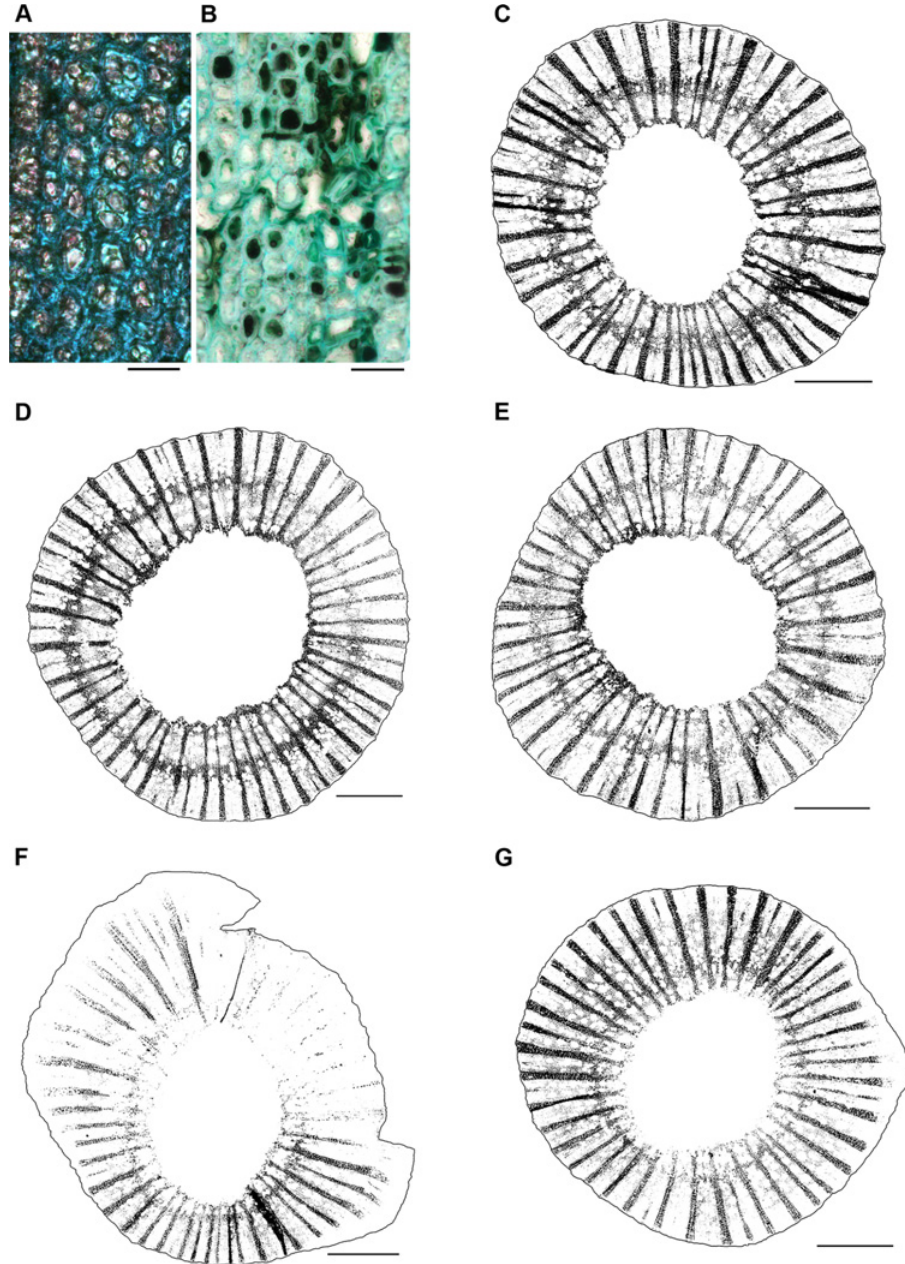
Fig 1. High levels of fungal colonization of the xylem fibers and rays were associated with starch depletion, especially at 2.0 MPI. (A) Xylem fibers of NIW plants contained starch (pink granules) and no hyphae, whereas those of IW plants (B) were devoid of starch, hence the drastic difference in stain absorption, and instead contained the darkly-pigmented hyphae of N . parvum (Bar, 25 μ m). Starch content was quantified from I 2 /KI — stained sections at 0 cm (binary images shown here) for (C) NINW, (D) IW-0.5 MPI, (E) NIW-0.5 MPI, (F) IW-2.0 MPI, and (G) NIW-2.0 MPI. (C-G) Starch-filled fibers and rays are black; starch-deficient cells are white. Bar, 1